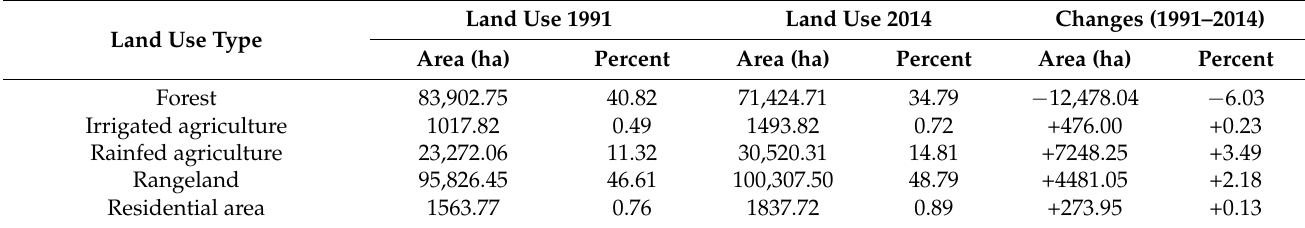
Table 3. The results of land use change between 1991 and 2014 in Talar watershed.